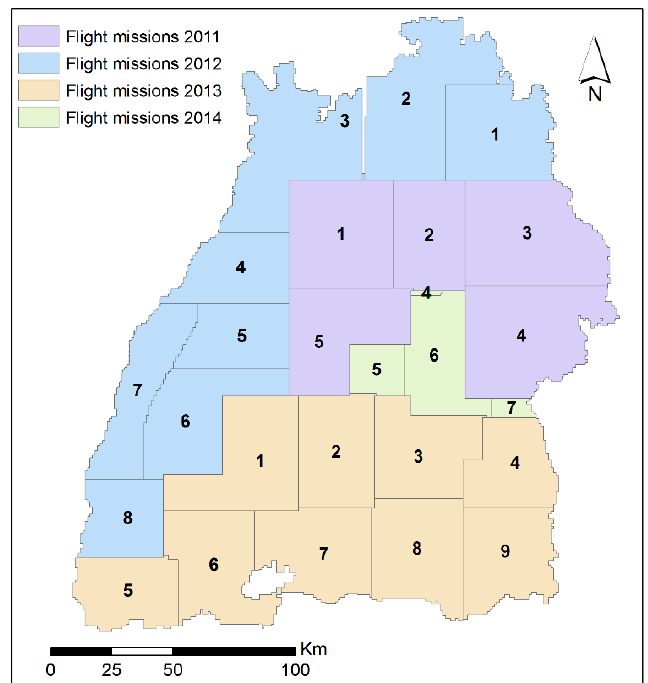
Figure 2. Flight missions in Baden-Württemberg between 2011 and 2014, showing parts of the flight missions used to derive the forest cover map.